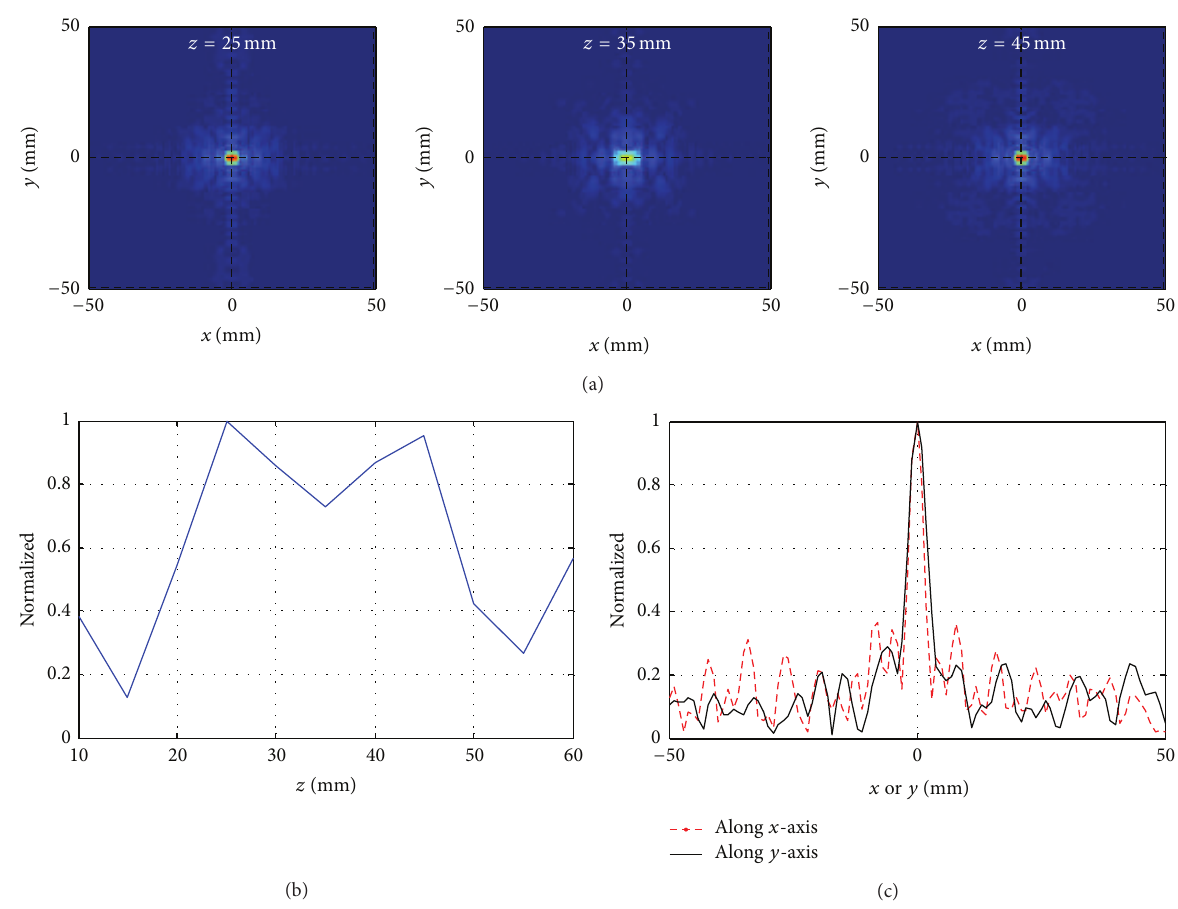
Figure 9: (a) Reconstructed images (shown every 10mm along 𝑧 and only at three range locations) when the distance between the reconstruction planes is Δ𝑧 = 5 mm for the example in Figure 6(b). Color bars are the same as in Figure 5. Normalized 1D magnitude of the reconstructed images along (b) range direction ( 𝑧 direction) and (c) cross-range directions ( 𝑥 and 𝑦 directions) in the plane of the object at 𝑧 = 45mm.